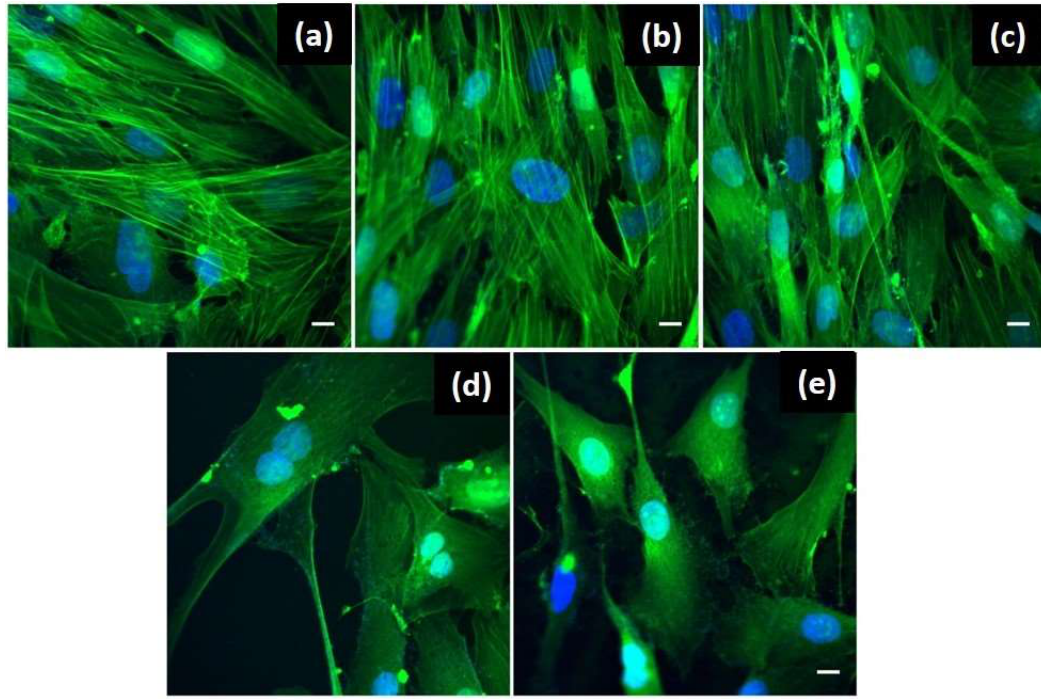
Figure 5. Confocal fluorescence microscopy images emphasizing the structural changes of the BJ